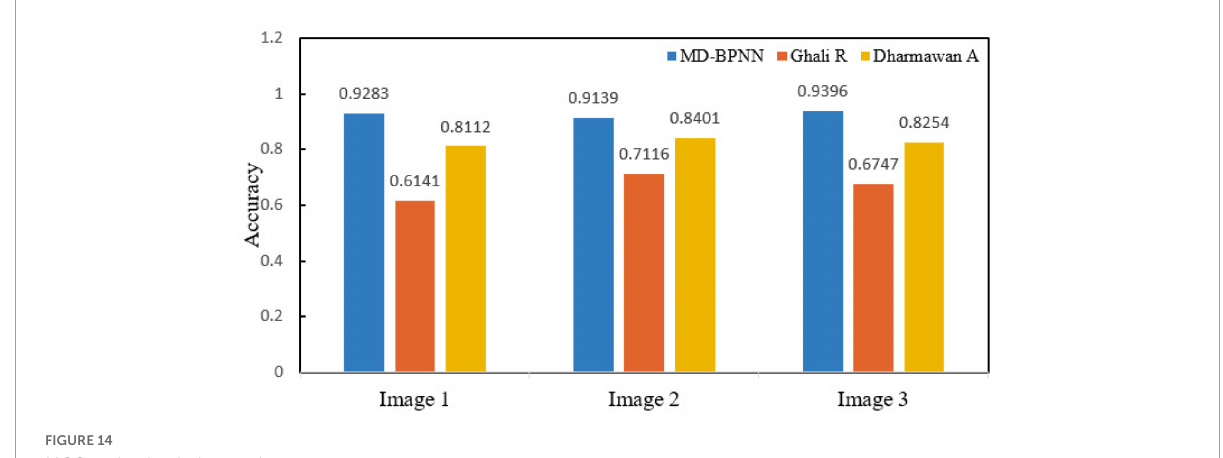
FIGURE14 MCC evaluation index